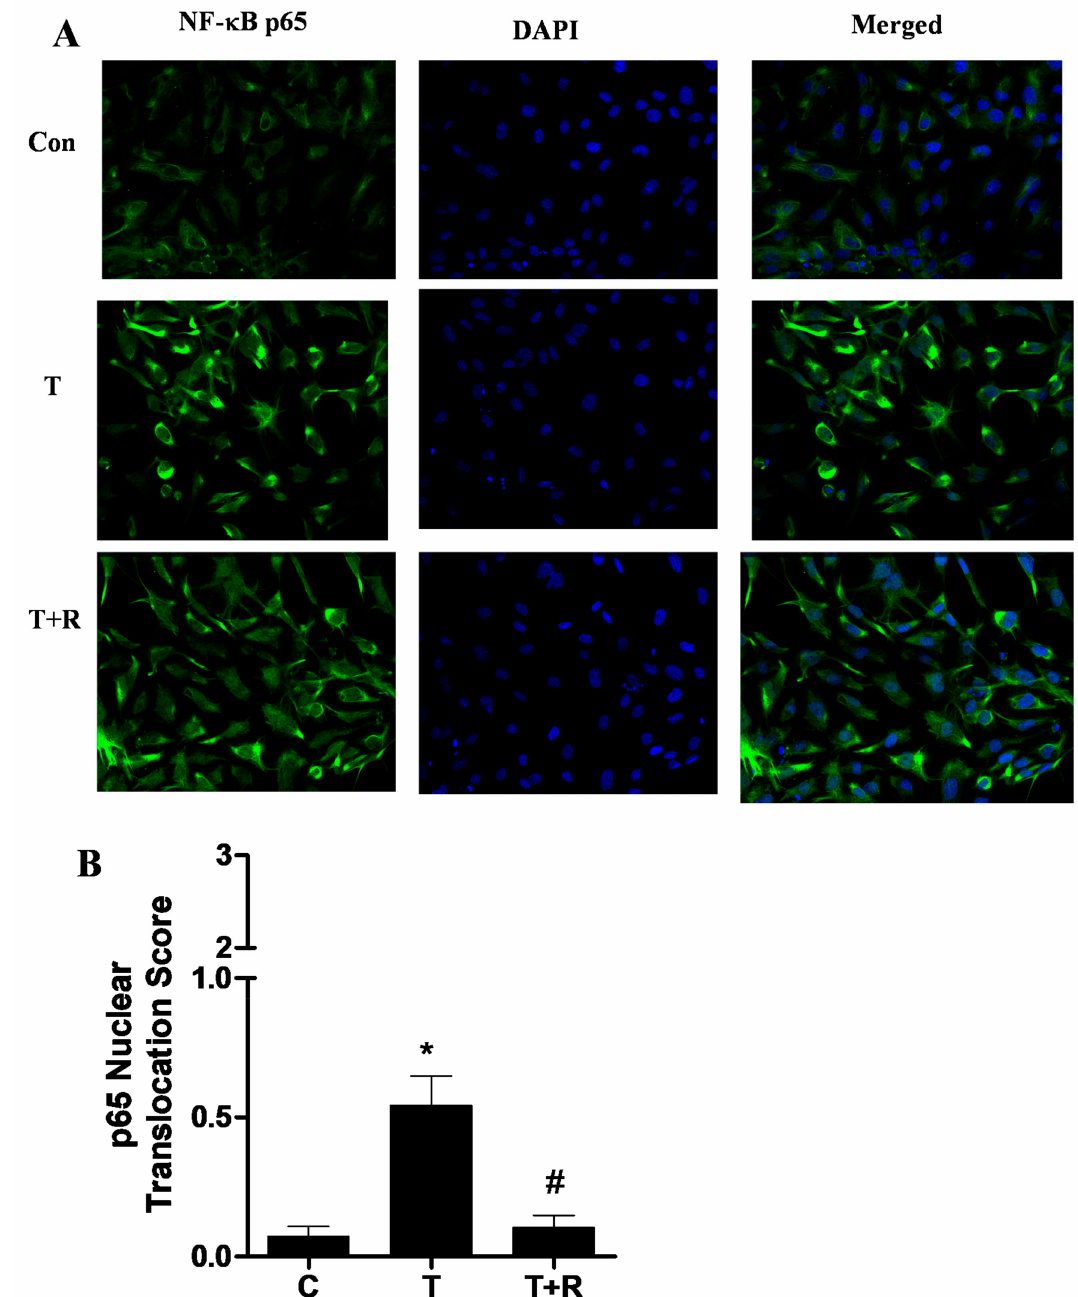
Figure 3. Resveratrol inhibited TNF- α -induced NF- κ B signaling in HUVECs. ( A ) The cells were pretreated with 1 µ m of resveratrol (R) for 1 h prior to the addition of TNF- α (T, 10 ng/mL) for 15 min in the continued presence or absence of resveratrol. Nuclear translocation of the NF- κ B p65 subunit was visualized by immunofluorescence staining of ECs. Representative immunofluorescence fields show NF- κ B p65 (green), nucleic acid with DAPI (blue), and overlay. ( B ) The nuclear and cytoplasmic fractions of p65 were quantified using a scoring system as described in Materials and Methods. *, p < 0.05 vs. control; #, p < 0.05 vs. TNF- α -alone-treated